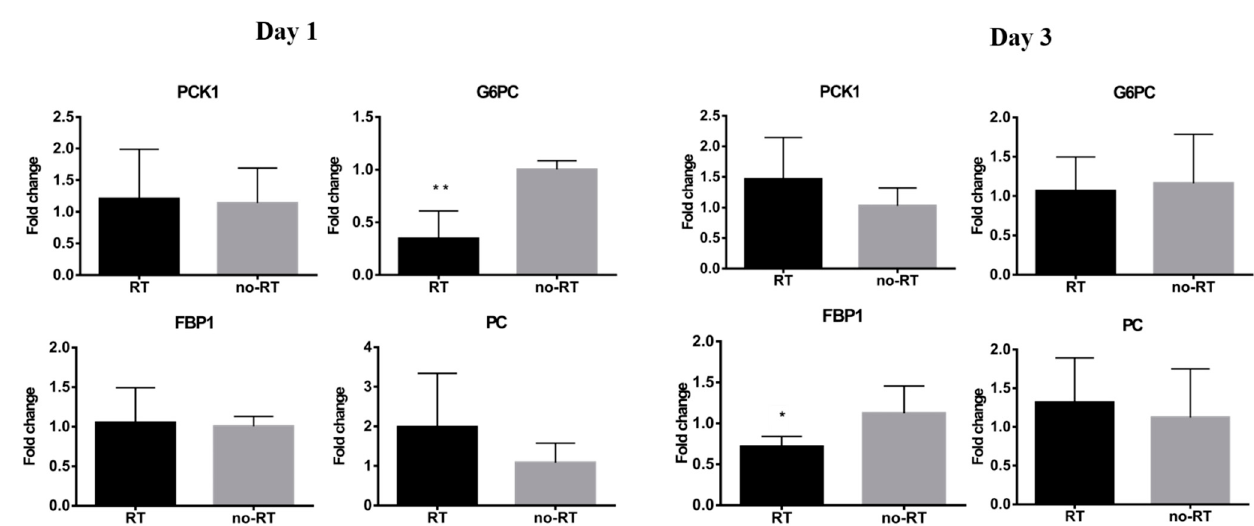
Figure 3. Expression levels of genes encoding for pro-inflammatory cytokines in the RT ( n ≥ 3) and no-RT ( n ≥ 3) groups on the first and third post-irradiation days (right lobe of the liver) . On the third post-irradiation day, the expression levels of the IL-6 gene (expressed as fold-change) were significantly increased in the RT group—but not in the no-RT group. ** p < 0.01